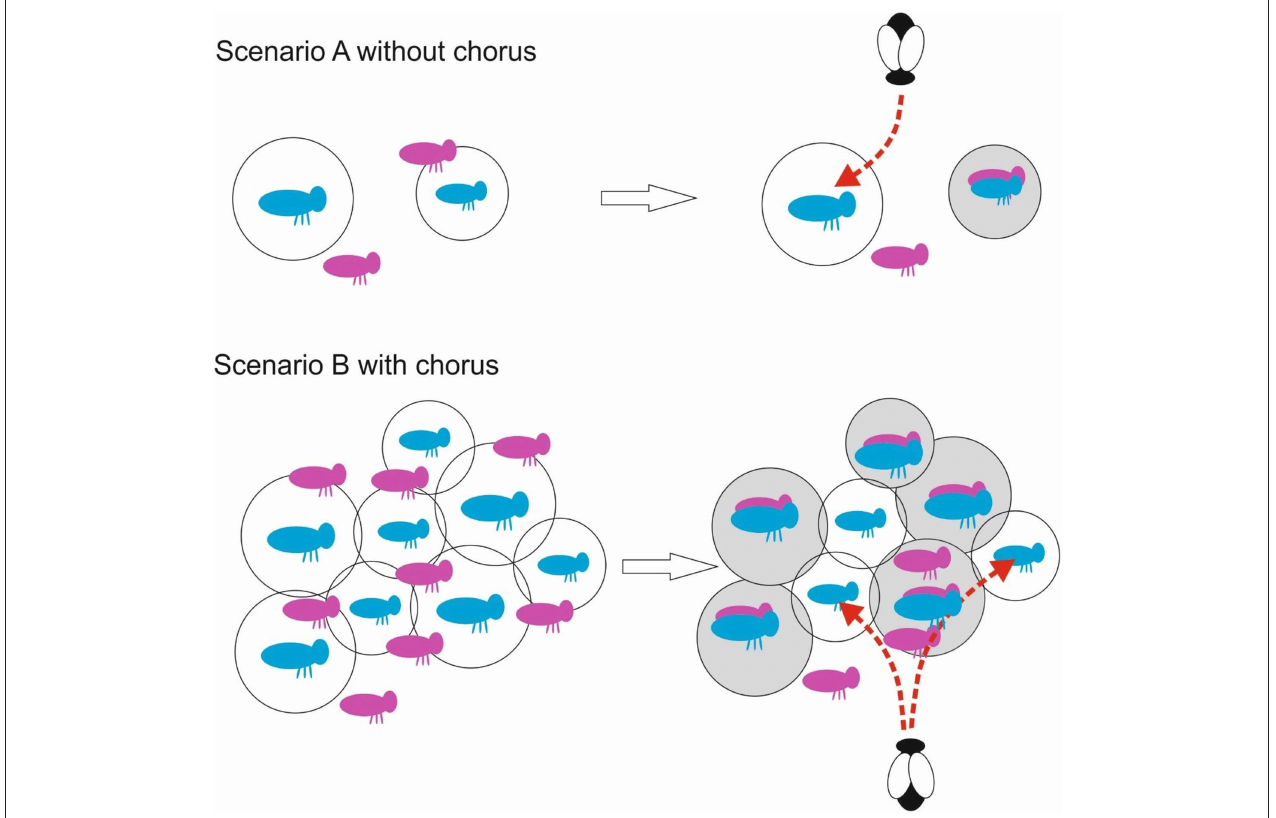
FIGURE 1 | Schematic illustration of possible chorus effect on parasitoids. Singing males (blue) are classified by their sound propagation as superior (large radius) and inferior (smaller radius). Scenario A: In a non-chorus situation, females (pink) may have limited choices, and might mate with an inferior male nearby, due to better sound representation in her nervous system. Overlaid figures indicate mating pairs. This male then stops singing for some time (indicated by a gray circle) and cannot be detected by the acoustically hunting parasitoid. A dipteran parasitoid might then attack the next sound producing male, which might be by chance a superior individual. Scenario B: In a chorus situation males and females are densely packed. Females which are in the broadcasting range of more than one male can select a superior one. As result more superior than inferior males mate and cease song production (gray circle). The parasitoid will affect mostly inferior singers. Some females might remain unmated, as more than one choose the same male (e.g., Lehmann and Lehmann, 2007) or are not in the broadcasting range.